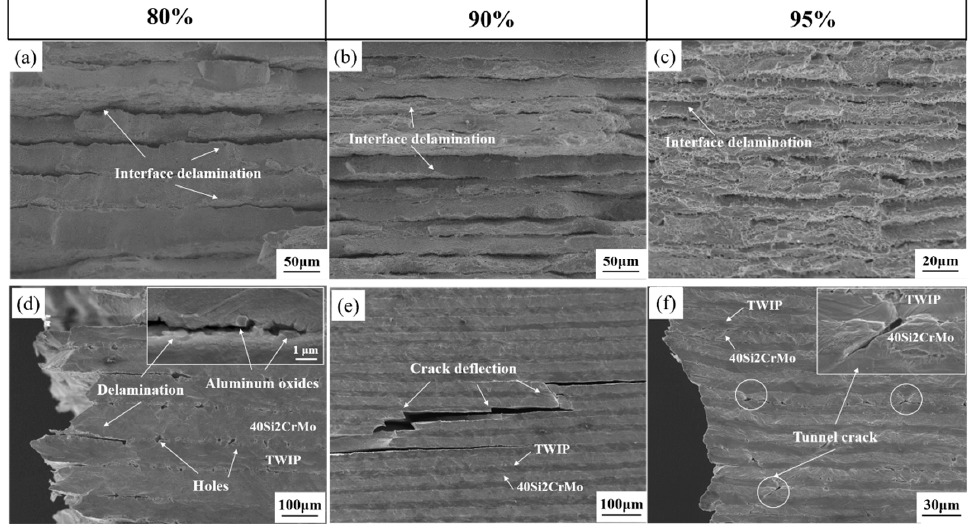
Figure 10. Tensile fracture morphologies of multilayer TWIP/40Si2CrMo steels with different hot rolling reductions: ( a – c ) the front fracture; ( d – f ) the side fracture.